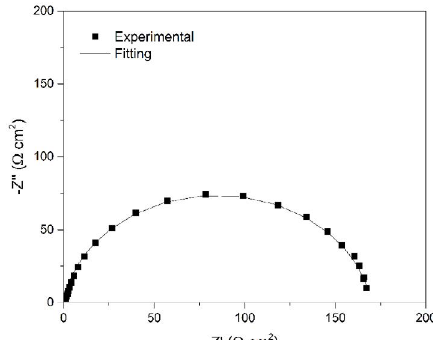
Figure 4. Nyquist diagram for the measured data in conversion bath at pH 2.5 (sample A) in 60 s of immersion. The solid line is the adjustment of the electric circuit